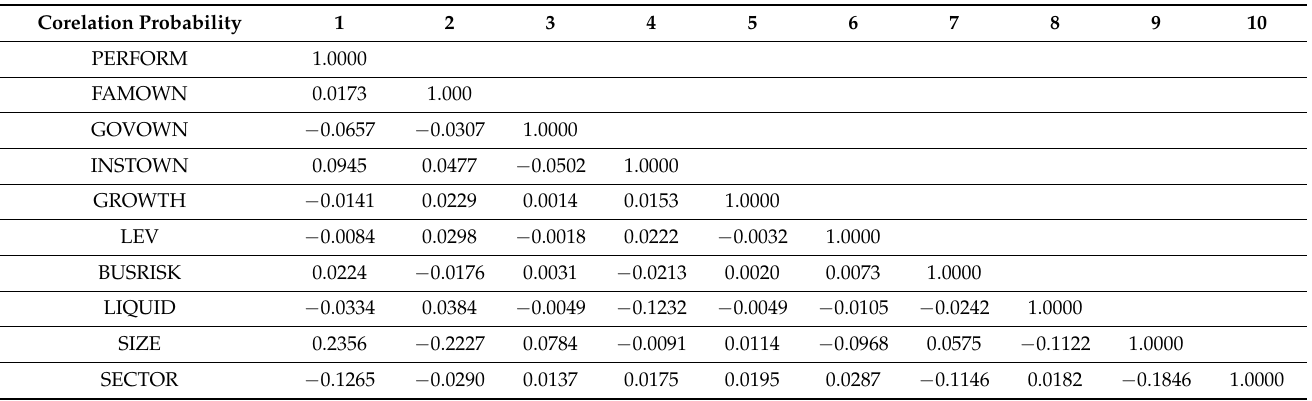
Table 3. Correlation matrix of the